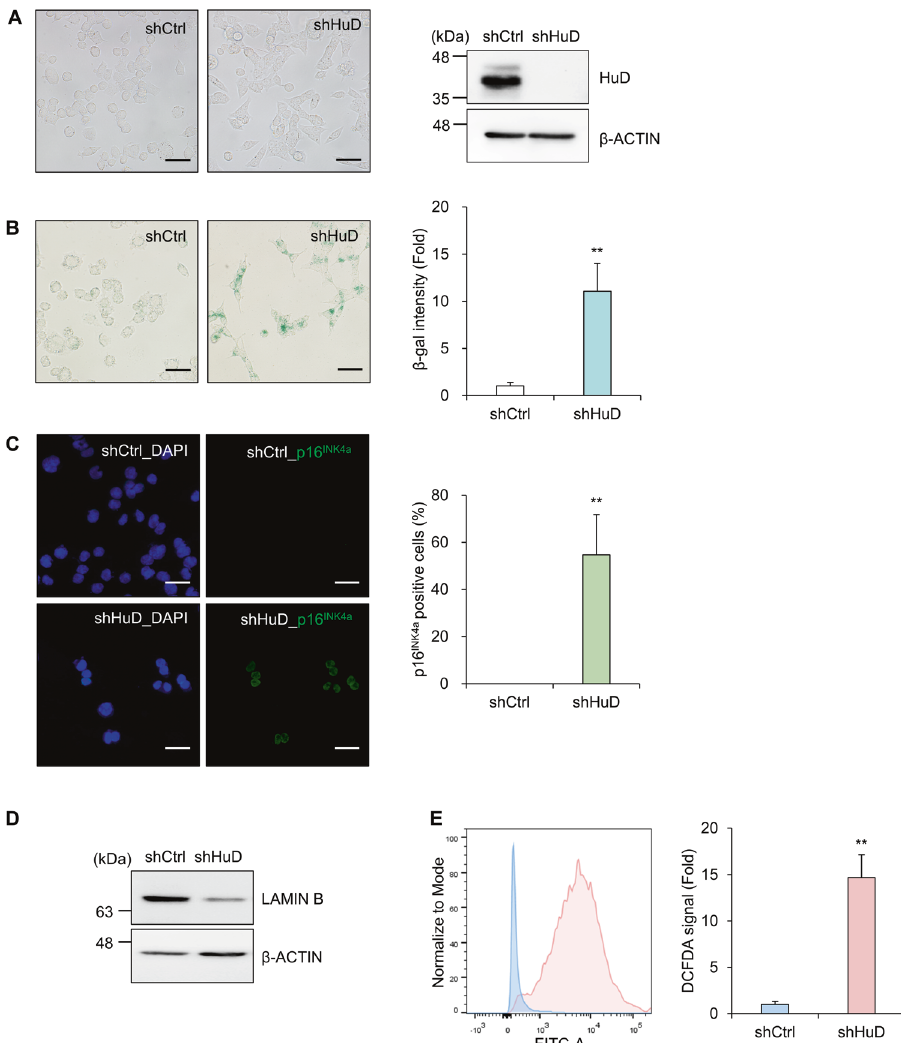
Fig. 1 Enhanced cellular senescence mediated via HuD downregulation. A Stable cells expressing short hairpin RNA against HuD (shHuD) or control RNA (shCtrl) were established using mouse neuroblastoma Neuro2A (N2a) cells. Downregulation of HuD was assessed via western blotting analysis. β -ACTIN was used as a loading control. B Cells were stained with senescence-associated β -galactosidase (SA β -gal). The relative intensity of SA β -gal was assessed via densitometric analysis using Image J. C The level of p16 INK4a was investigated via immuno fl uorescence microscopy and quanti fi ed by counting the number of p16 INK4a -expressing cells. Green: p16 INK4a , blue: nuclei. D The level of LAMIN B was assessed via western blotting analysis. β -ACTIN used as a loading control. E Cells were incubated with DCFDA, a fl uorescent indicator of ROS and cellular ROS levels between N2a_shCtrl and N2a_shHuD cells were determined using fl ow cytometry. Images are representative, and data indicate the mean ± SEM from three independent analyses. Scale bar, 50 μ m. The statistical signi fi cance of the data was analyzed via Student ’ s t -test; ** p <